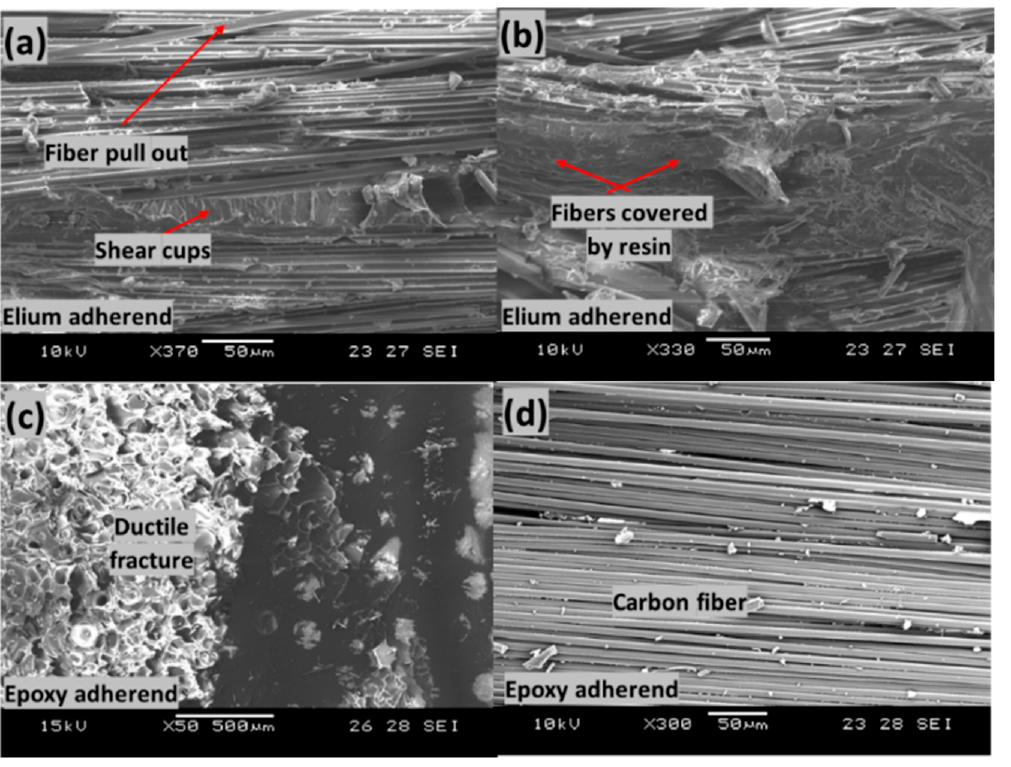
Figure 18. SEM fractography of EL-EP_0.25 with maximum LSS. ( a , b ) Elium adherend and ( c , d ) epoxy adherend.